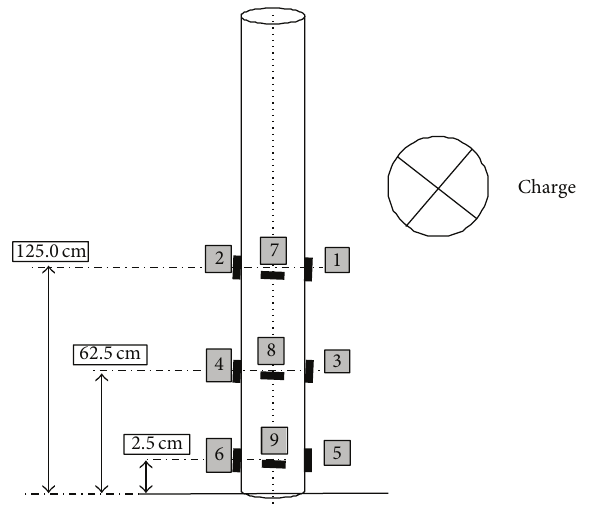
Figure 2: Strain gauges